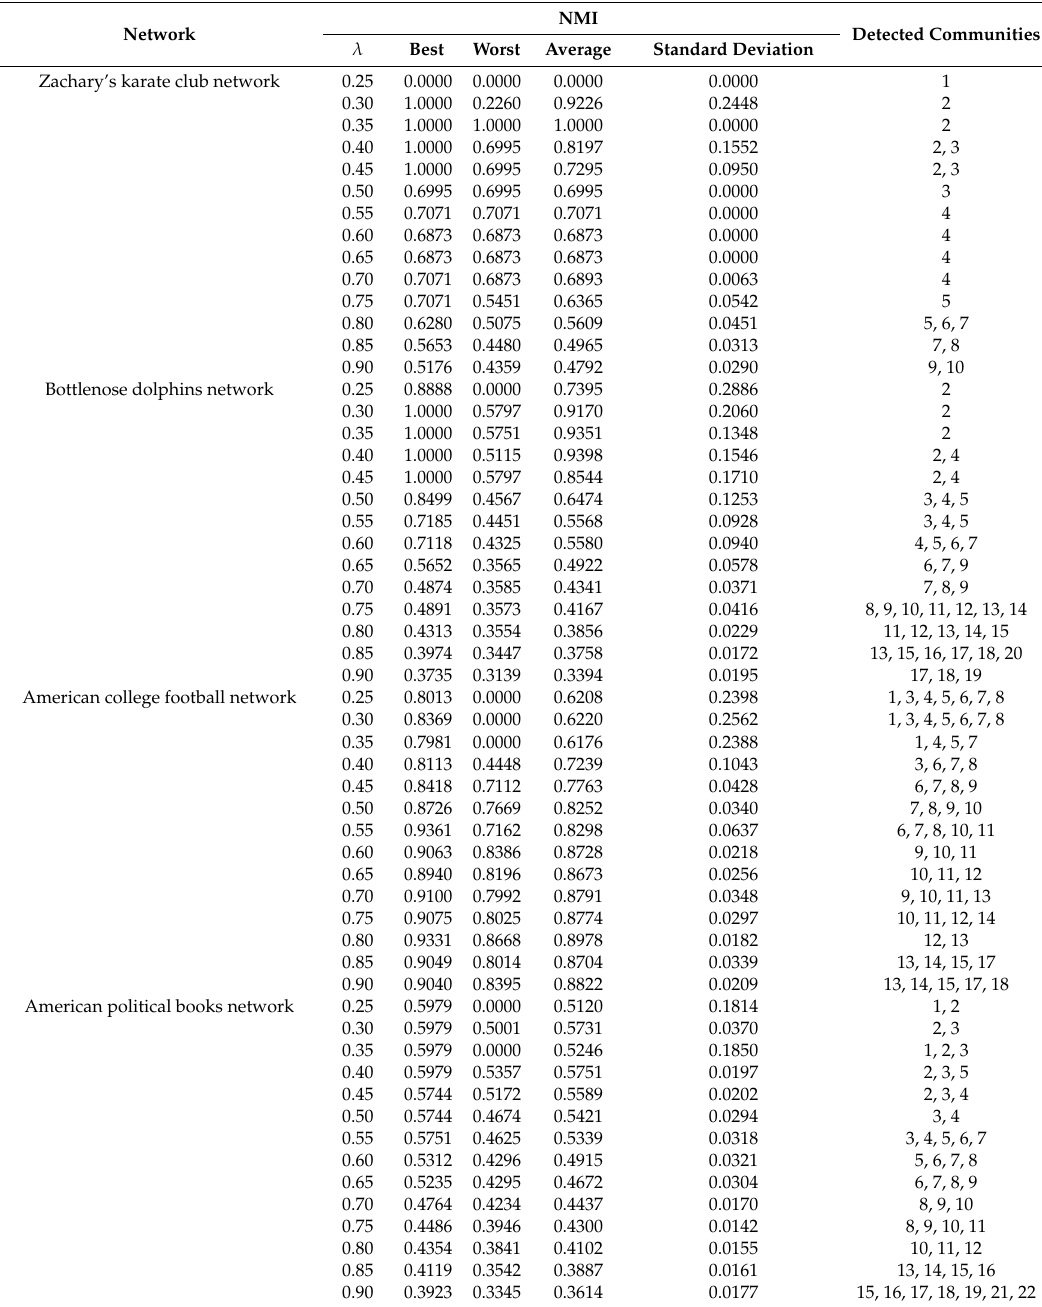
Standard Deviation